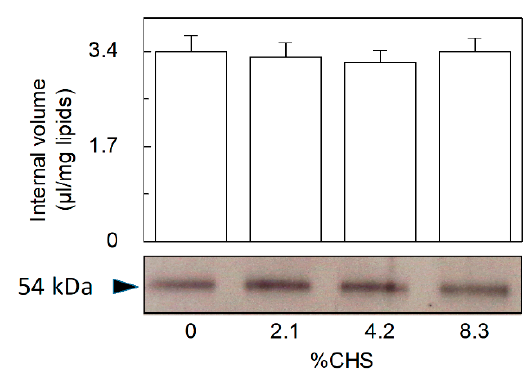
Figure 4. Effect of CHS on the internal volume of the proteoliposomes. The recombinant OCTN1 was reconstituted in liposomes as described in Section 4.5. except that in proteoliposomes batches used for each time course experiment were reconstituted in the presence of 0 ( ○ ), 2.1 ( ● ), 4.2 ( □ ), 8.3 ( ■ ) % CHS (corresponding to 0, 21, 42, and 83 µg CHS/mg total lipids, respectively). Internal volume of proteoliposomes was measured as described in Section 4.5. (upper panel). Immunodetected OCTN1 bands (anti-His antibody, as described in Section 4.9) from the different proteoliposomes preparations (lower panel). The relative concentration of the immuno-stained proteins, normalized to the 0 % CHS (considered as 100%) was 109 ± 14% (2.1% CHS); 104 ± 5.8% (4.2% CHS); 106 ± 9.1% (8.3% CHS), as derived from three different experiments (± S.D.).